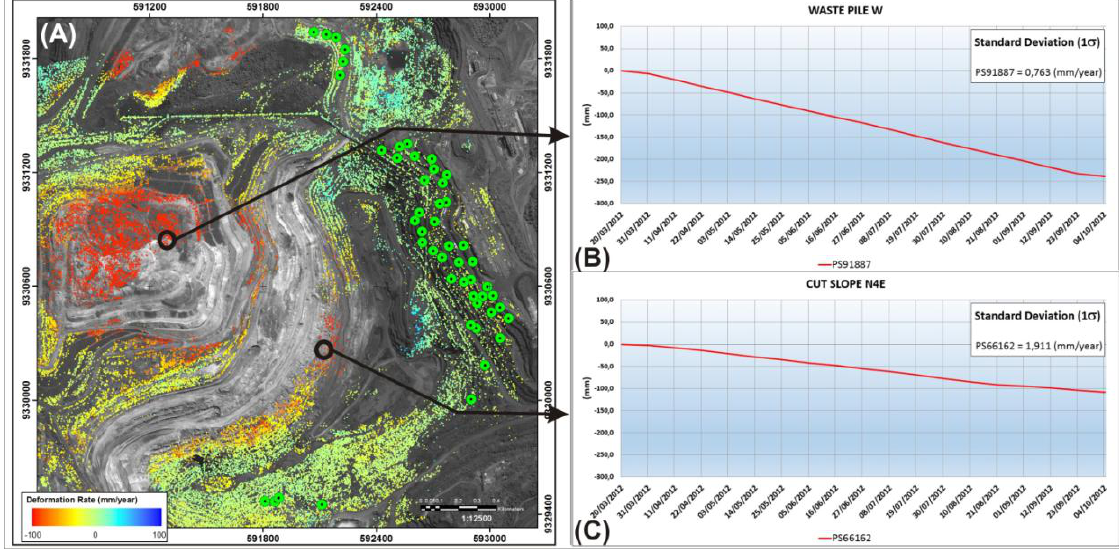
Figure 3. (A) Spatial distribution of PSs (IPTA) using the first 19 TSX-1 images for N4E mine, visualized by the average LoS velocity (mm/year) on the panchromatic GeoEye image. Large green circles show the location of prisms. Areas without PS are indicative of low coherence due to rapidly changed surfaces, (B) TSX-1 deformation profile related of a PS located over the waste pile W, (C) TSX-1 deformation profile of a PS located on a cut slope in the central flank of the pit of N4E